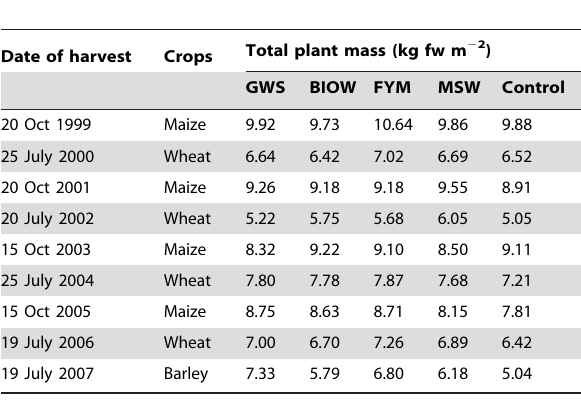
Table 6. Calculated total mass of harvested plant parts (from results in dry weight, please see Text S2, Table